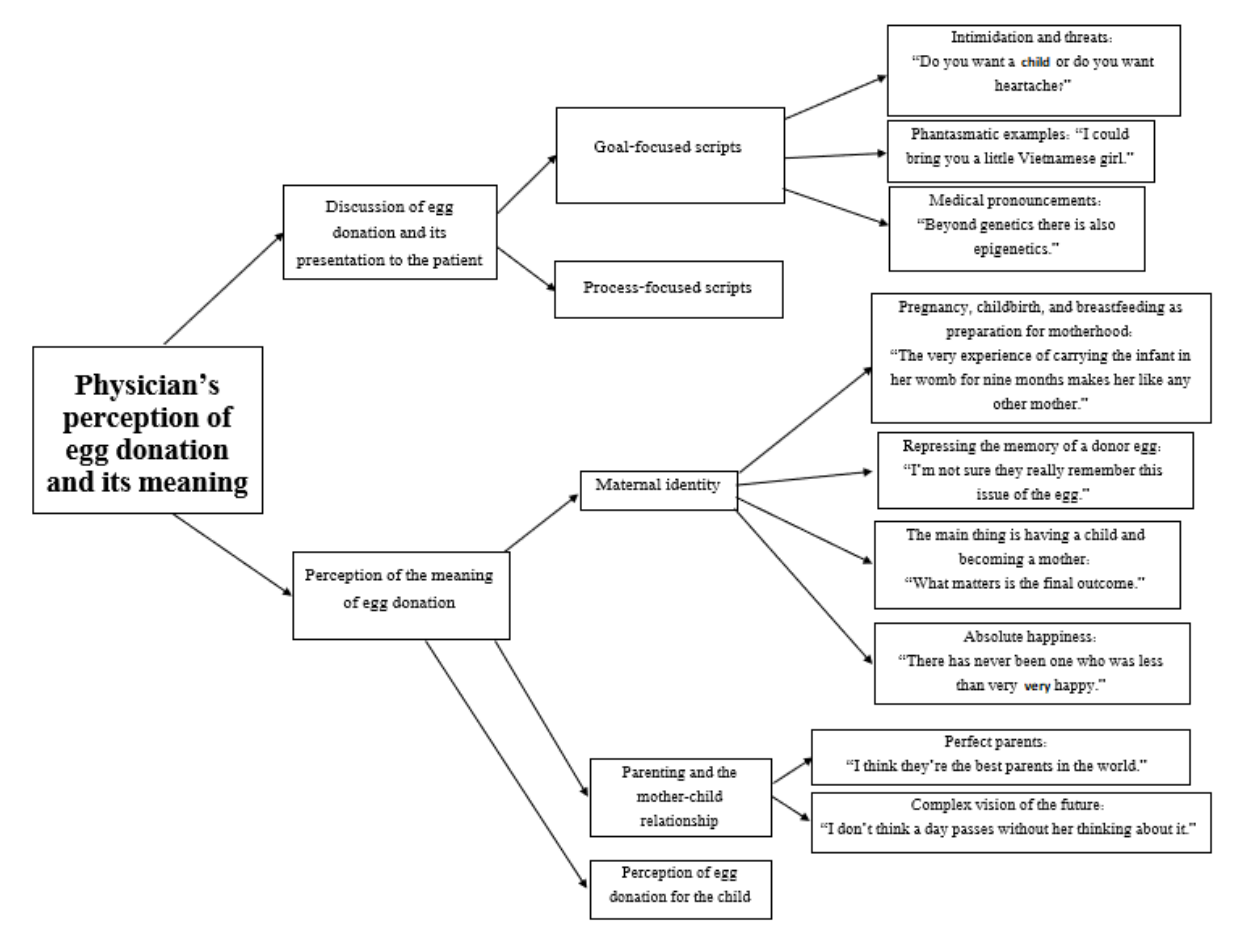
Figure 1. Categories and themes.